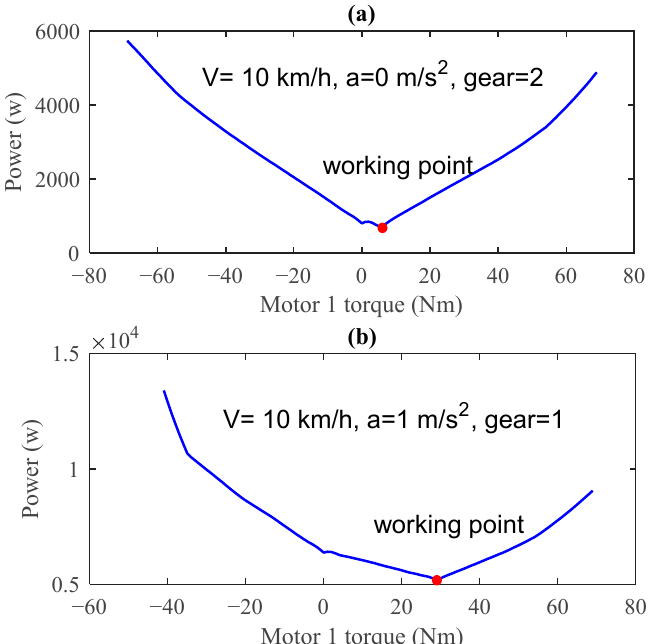
Figure 3. Objective function value of different driving conditions.